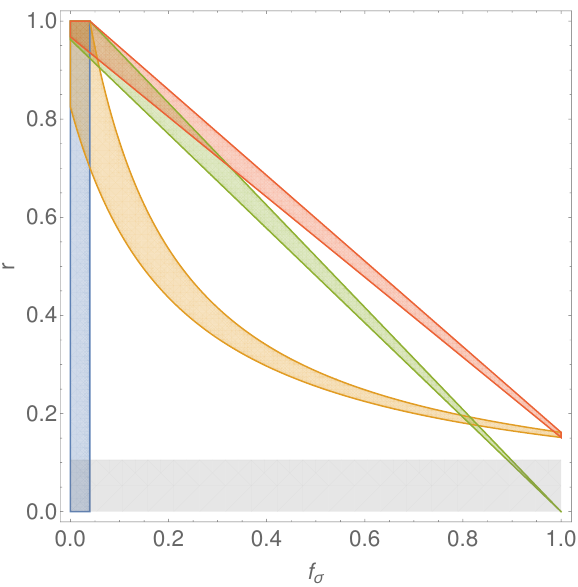
Figure 4 . Possible range of r dec and f (cid:27) for 4 di(cid:11)erent scenarios, with the isocurvature constraint. Blue, green, orange and red regions stand for b after ; c after / b by ; c after / b after ; c by and b by ; c by respec- tively. The gray shade is vetoed as r dec becomes too low and introduces too large a f local